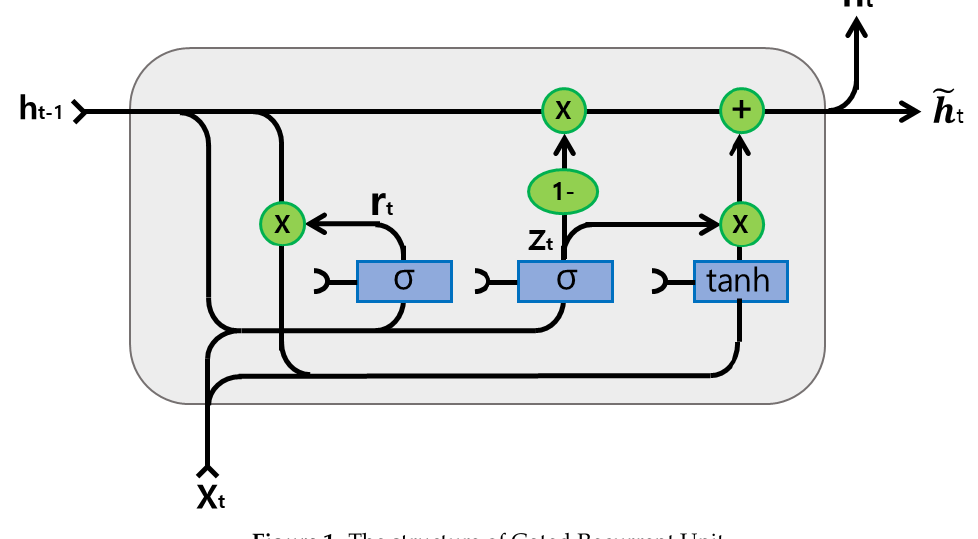
Figure 1. The structure of Gated Recurrent Unit.